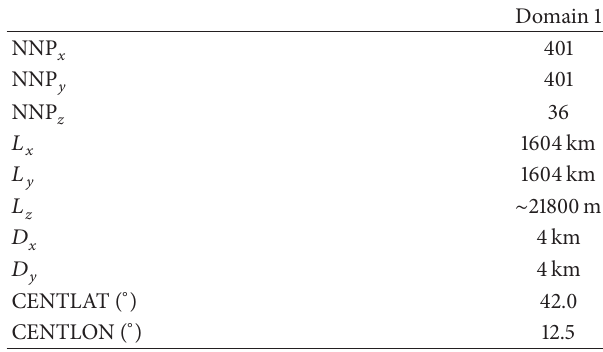
Table 1: RAMS grid-setting. NNP 𝑥 , NNP 𝑦 , and NNP 𝑧 are the number of grid points in the west-east, north-south, and vertical directions. 𝐿 𝑥 (km), 𝐿 𝑦 (km), and 𝐿 𝑧 (m) are the domain extension in the west-east, north-south, and vertical directions. 𝐷 𝑥 (km) and 𝐷 𝑦 (km) are the horizontal grid resolutions in the west-east and north-south directions. CENTLON and CENTLAT are the geographical coordinates of the grid